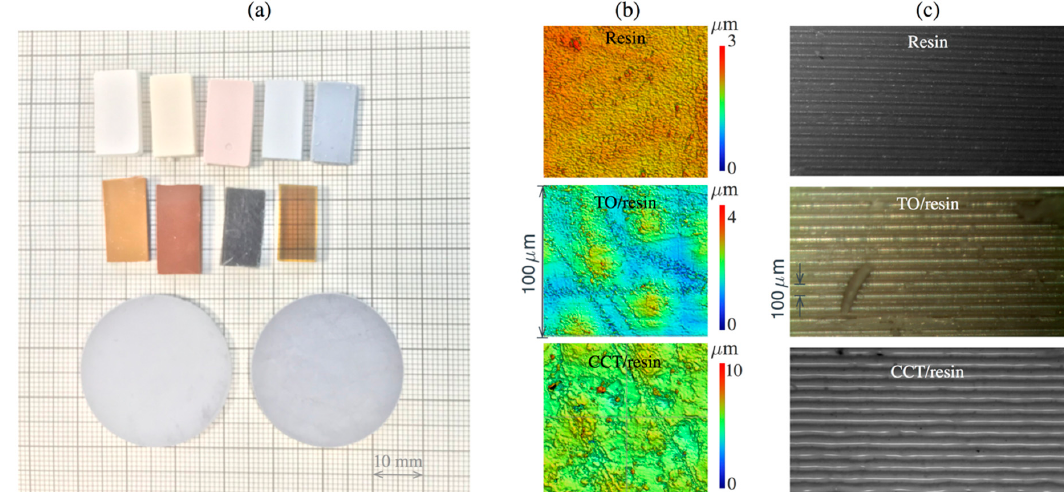
Figure 4. ( a ) Examples of the 3D-printed samples with various content of the dielectric ceramic fillers (smallest square of the background represents 1 mm). The colour and transparency of the samples are the function of loaded particles and grade of the photopolymer. The rectangular-shape blocks were printed to be fitted into the waveguide flange while disks were used for the split-post resonator. ( b ) Topography of the as-printed top surface (xy-plane) for 3DP un-filled resin and TO and CCT filled 10% w/v composites. ( c ) Side (zx-plane) of the as-printed samples showing the build layers.